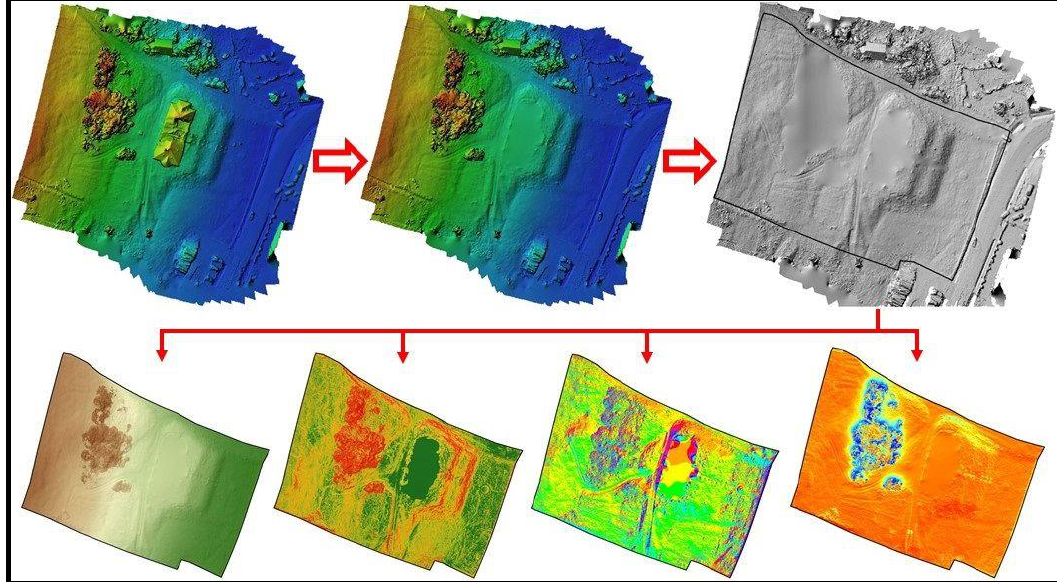
Figure 8. Spatial analysis stages of the surrounding heritage area.